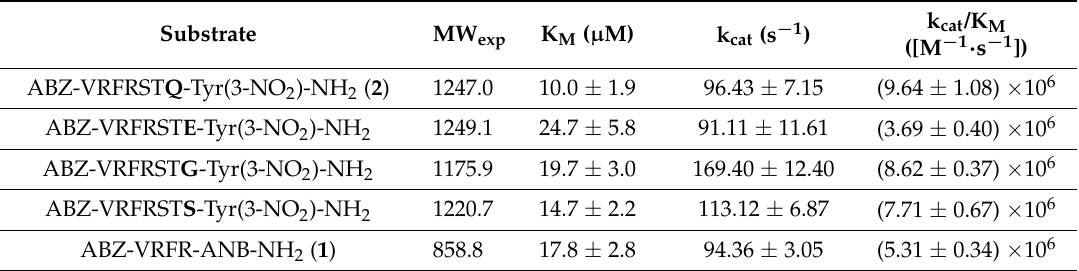
Table 2. Kinetic parameters of the selected KLK13-specific substrates. MW exp represent the MS-TOF measured average mass of the